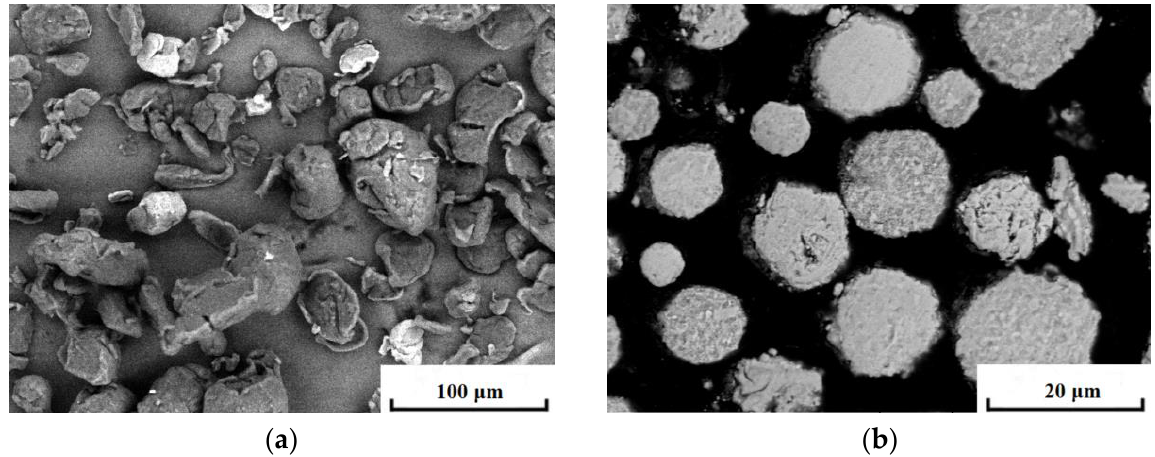
Figure 1. Morphology ( a ) and cross-sectional microstructure ( b ) of the ceramic powder by SEM [16].